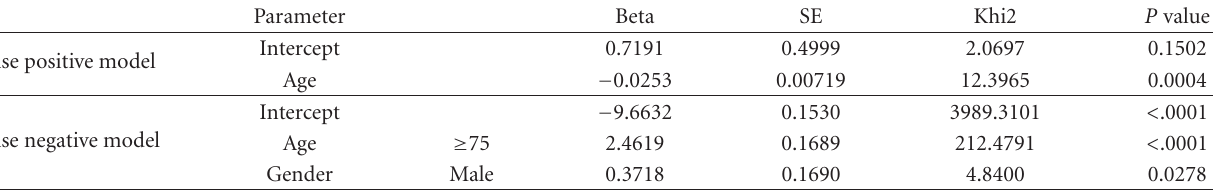
Table 4: Coe ffi cients and standard errors of the predictive models estimated from the regional data (Cˆote d’Or and Doubs). Parameter Beta SE Khi2 P